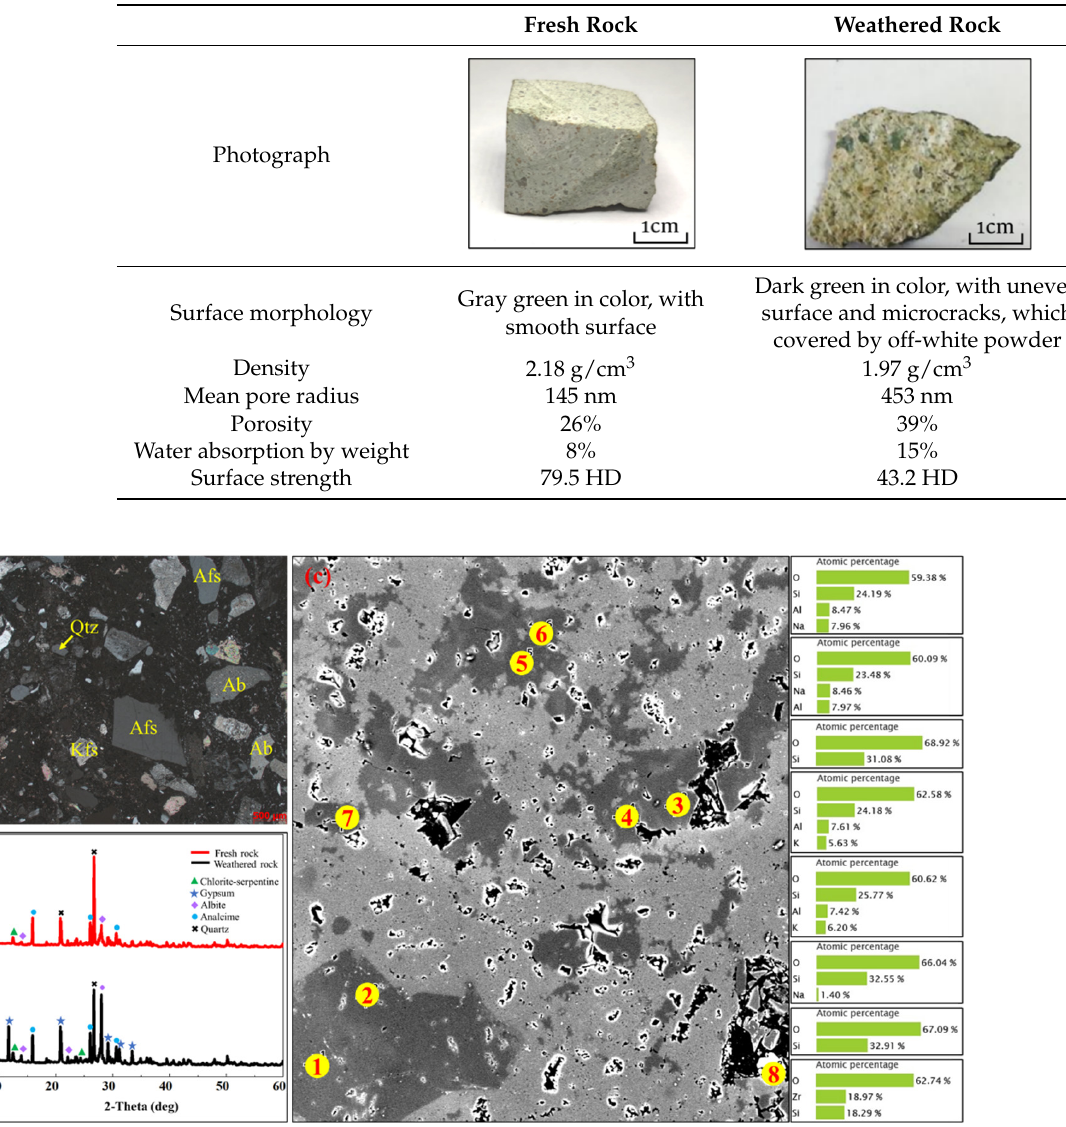
Table 1. Physical mechanical properties of rock from Sanlao stone house.